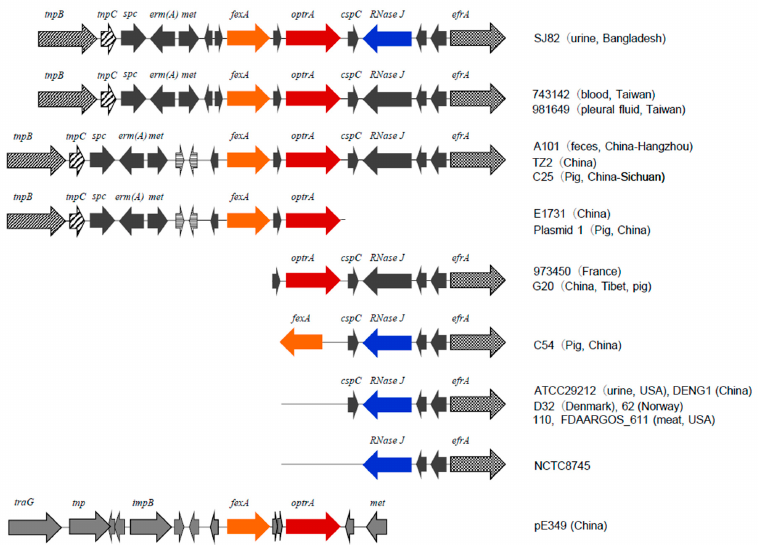
Figure 2. Schematic representation of the genetic background of optrA in the E. faecalis strain SJ82 (uppermost) and the genetic organization or components similar to that of SJ82 in other strains reported previously [30] or available in GenBank database. Prototype of the fexA–optrA cluster in the pE349 of E. faecalis strain E349 [22] is shown at the bottom. Arrows indicate the transcription direction of genes. Arrows of RNase J are shown in black and blue, representing different sequences. Gene names are shown above arrows, and the strain names are indicated on the right.